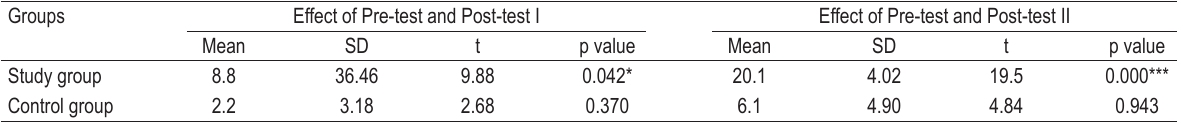
TABLE 4. Paired t test between Pretest and Post‑test I and II of Study and Control Group (n=30) Groups Effect of Pre‑test and Post‑test